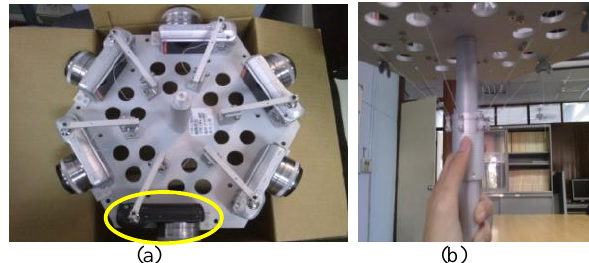
Figure 2. (a) The top view of the platform; (b) The bottom view of the platform.